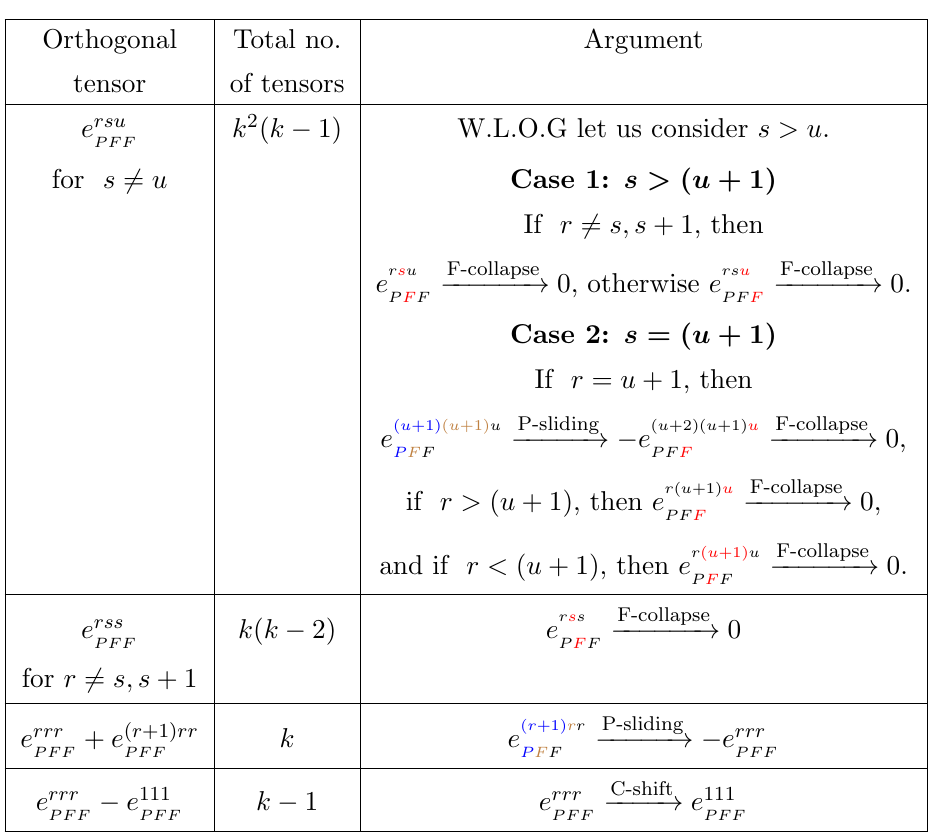
Table 4 . Arguments for the tensors in the PFF sector orthogonal to the array of 3 point contour